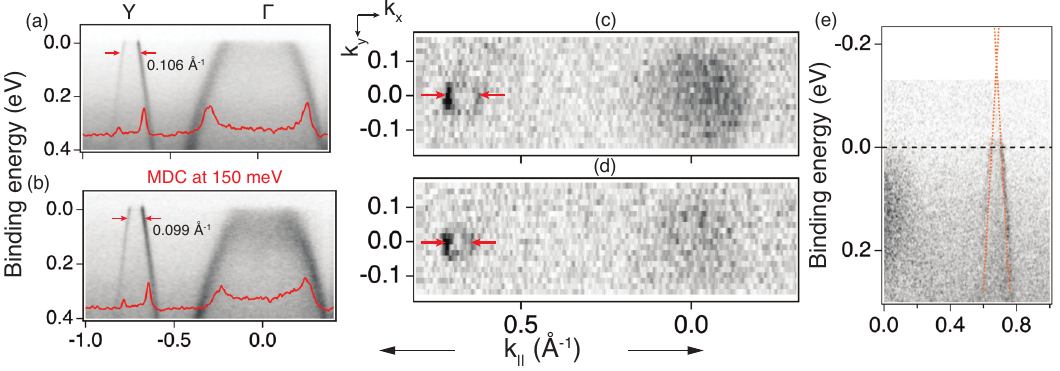
Figure A2: Alkali metal decoration shifts Fermi level upward ARPES data recorded along Γ - X at the I05 beamline before and after K metal was evaporated onto the cleavage surface of SrMnSb at 10 K. Panels (a) and (b) show I(E,k || ) images, recorded along Γ − X, before and 2 after the first K evaporation, respectively. The red traces are overlays of MDC’s for E = 150 meV. Panels (c) and (d) are from a different cleave, and show constant energy maps for E = 50 meV, before and after another K evaporation experiment. For both K evaporation experiments [ (a) vs. (b), or (c) vs. (d) ] , red arrows indicate the decrease in the k -space separation between the left and right branches consistent with an upward shift in E on K decoration. Panel (e) shows F an I(E,k || ) image for a Γ − X cut for the most shifted situation arrived at via K evaporation. The orange dashed lines extrapolate towards a putative crossing, now at ca 140 meV above E . All F data are measured with 88 eV photon energy at 10